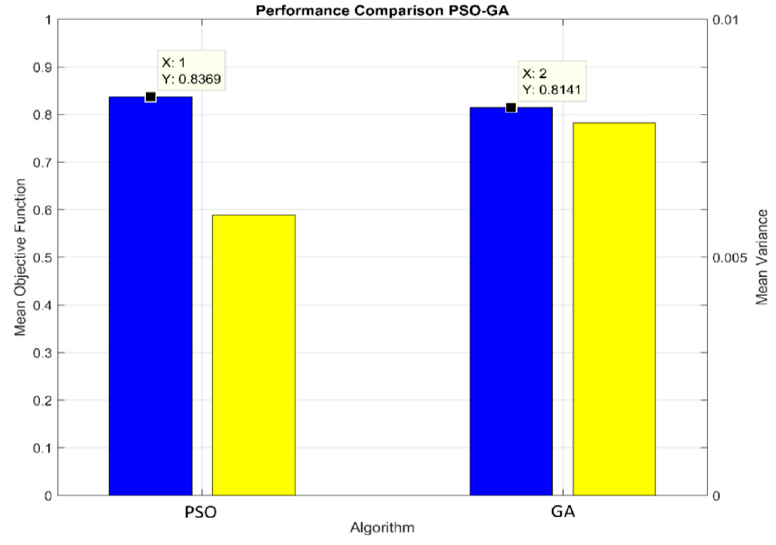
Figure 13. Performance comparison between the PSO and the GA.